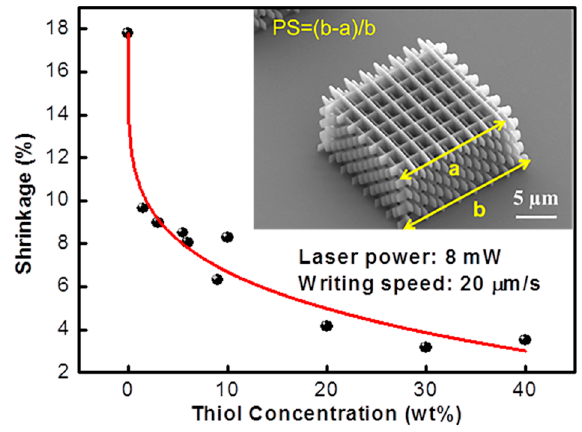
Figure 6. Shrinkage of a TPP microstructure using acrylic resins with different concentrations of multifunctional thiol molecule. The red line is used as a guide to the eye. A SEM image of the microstructure with the definition of percentage of shrinkage (PS) used in this study is shown in the inset. Reproduced from [32].